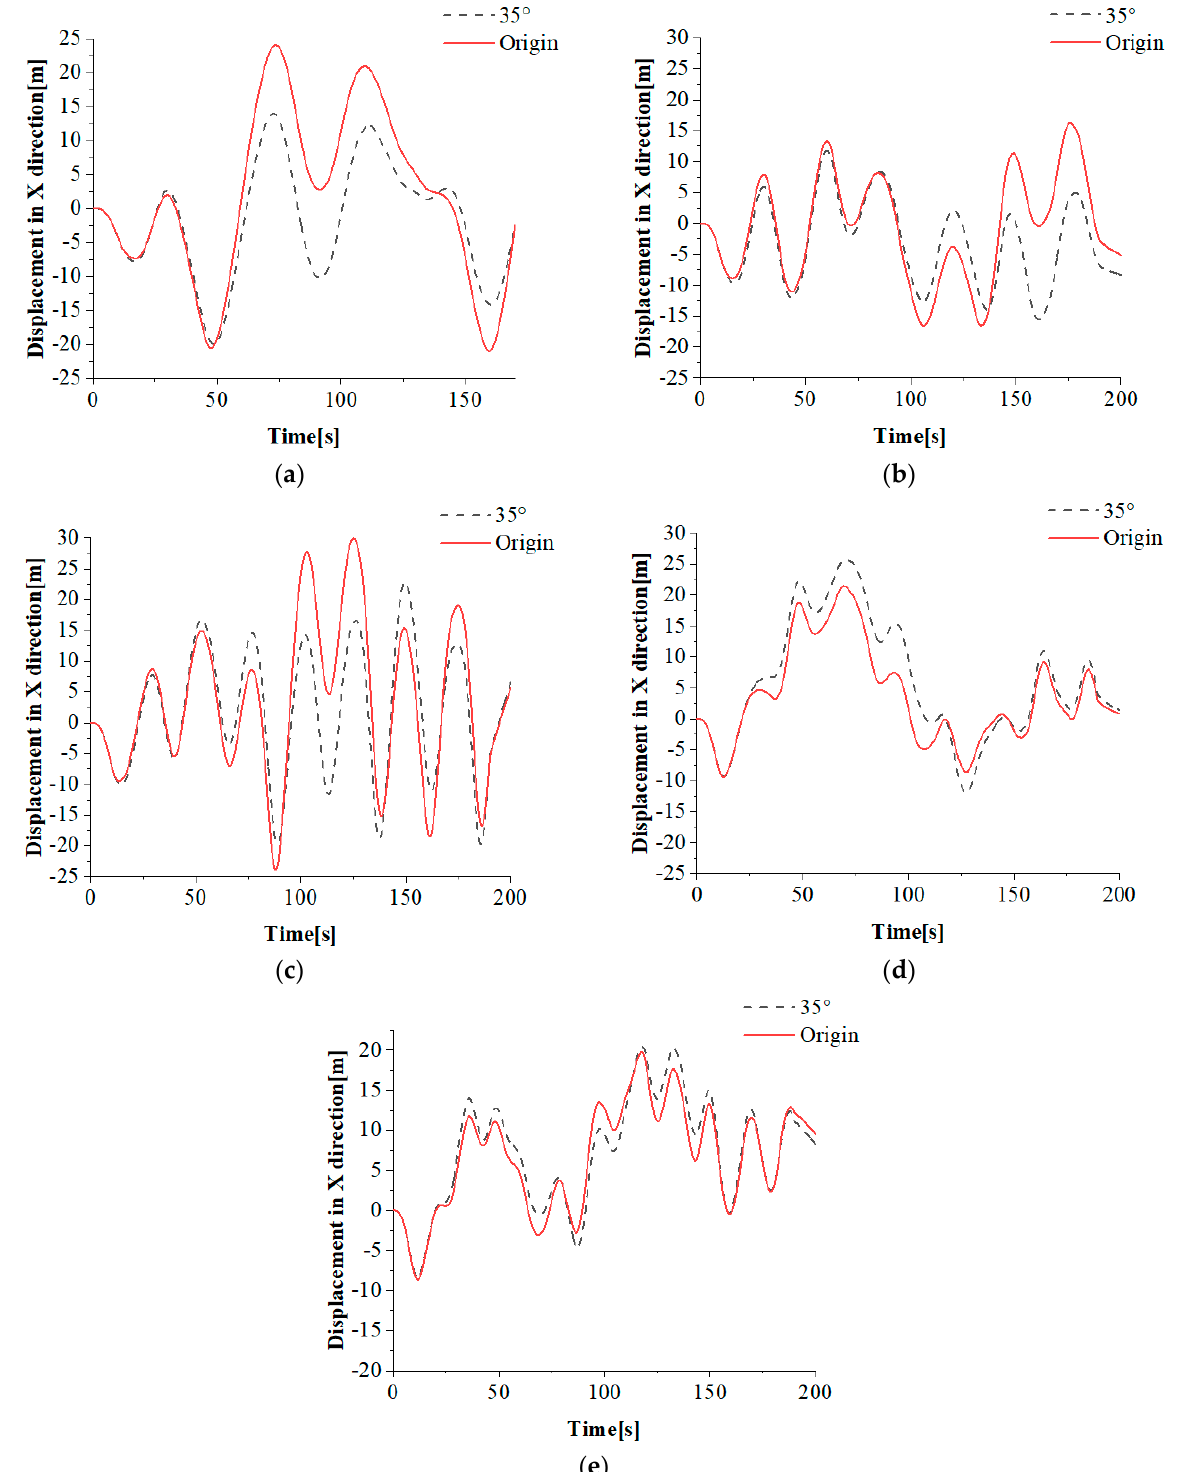
Figure 32. X direction displacement of the pedestal under different wave periods. ( a ) T = 38.73 s; ( b ) T = 30.98 s; ( c ) T = 25.82 s; ( d ) T = 22.13 s; ( e ) T = 19.36 s.